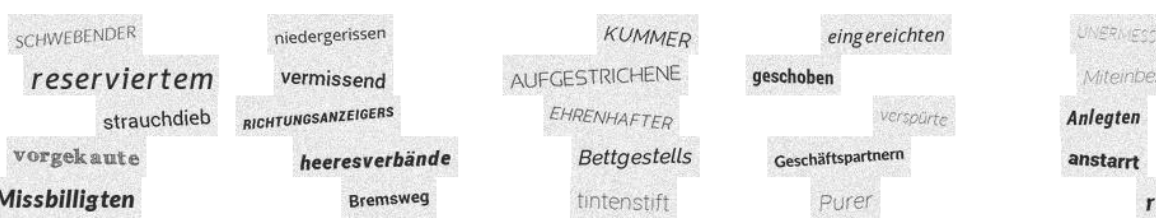
Figure 12. The evolution of both training and validation performance over the epochs; here, we show the first 200 epochs.